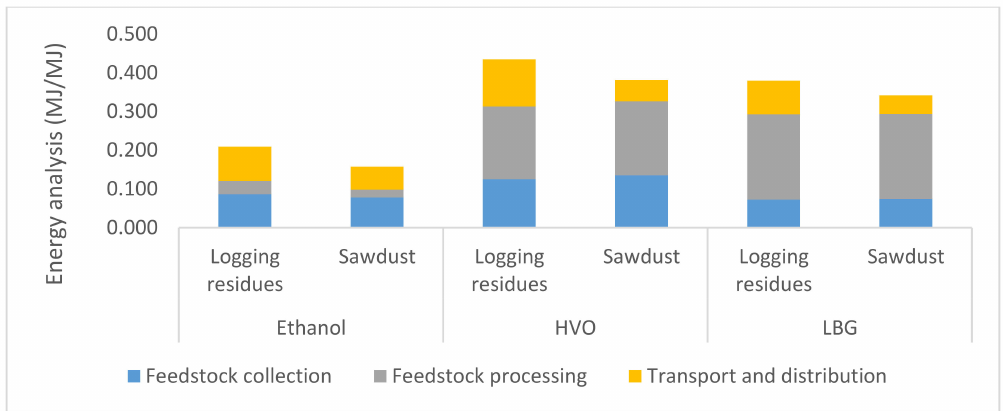
Figure 3. Energy analysis (MJ / MJ) for ethanol, HVO, and LBG from logging residues and sawdust.